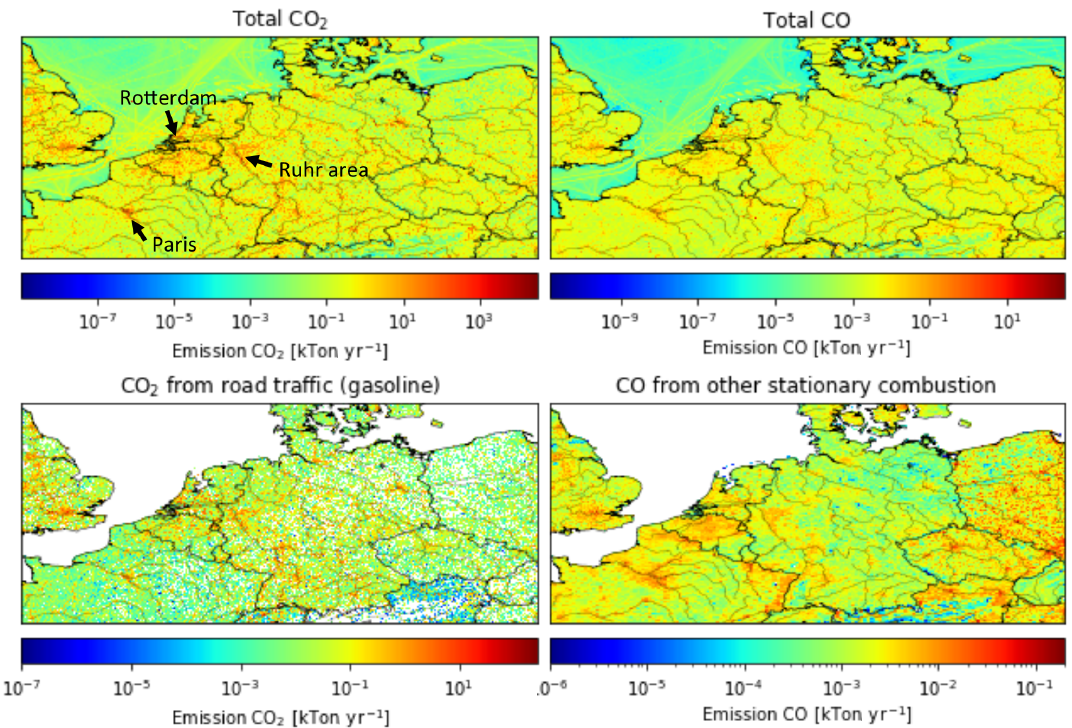
Figure 1. Total emissions of CO 2 and CO, road traffic (gasoline) emissions of CO 2 and other stationary combustion emissions of CO for 2015 in ktyr − 1 (defined per grid cell).